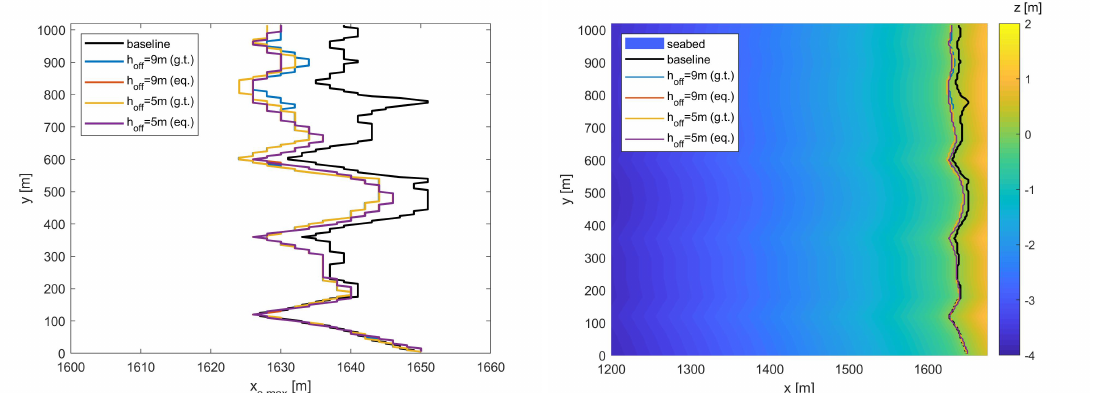
Figure 14. Comparison of max inundation due to the NNE forcing: results of baseline (black line) and flood (colored lines) simulations ( left panel ). The overlap with the original bathymetry is also shown ( right panel ).